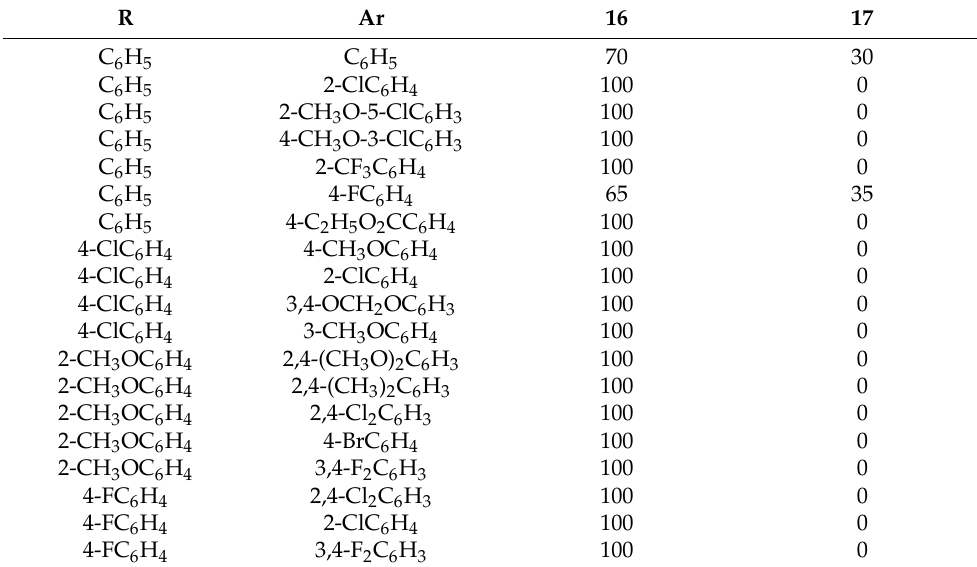
Table 1. The composition of the reaction